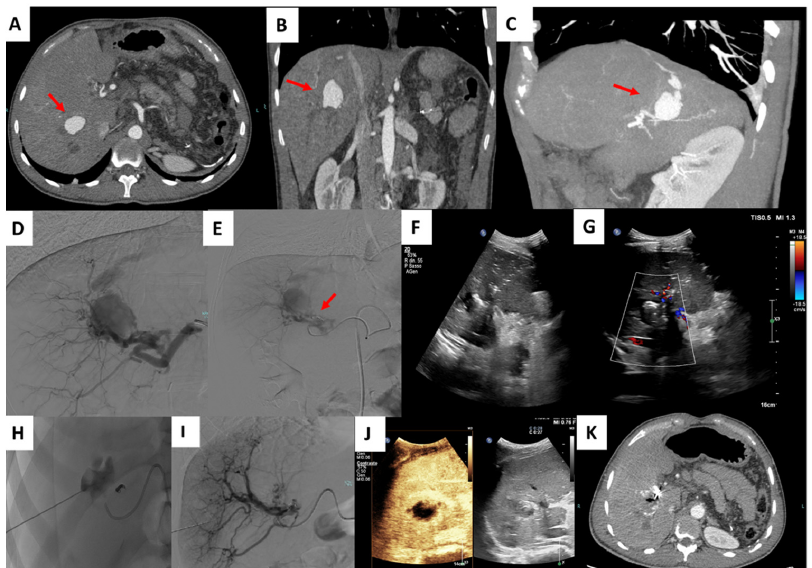
Figure 1. Percutaneous treatment of an intra-parenchymal PSA. Contrast enhancement CT (CECT) shows a right intrahepatic PSA: Axial ( A ), coronal ( B ) and MIP reconstruction ( C ). Selective right hepatic artery angiogram confirmed the presence of the PSA ( D ). After proximal embolization with microcoils (arrow), the angiogram demonstrated the persistence of the PSA ( E ). Percutaneous US guided puncture was performed ( F , G ). Saccography confirmed the correct position of the needle ( H ). Final angiogram demonstrated the complete exclusion of the PSA ( I ). Immediately after proce- dural contrast enhancement US (CEUS) confirmed the complete embolization of the PSA ( J ). CECT performed during follow up further confirmed exclusion of the PSA ( K ).